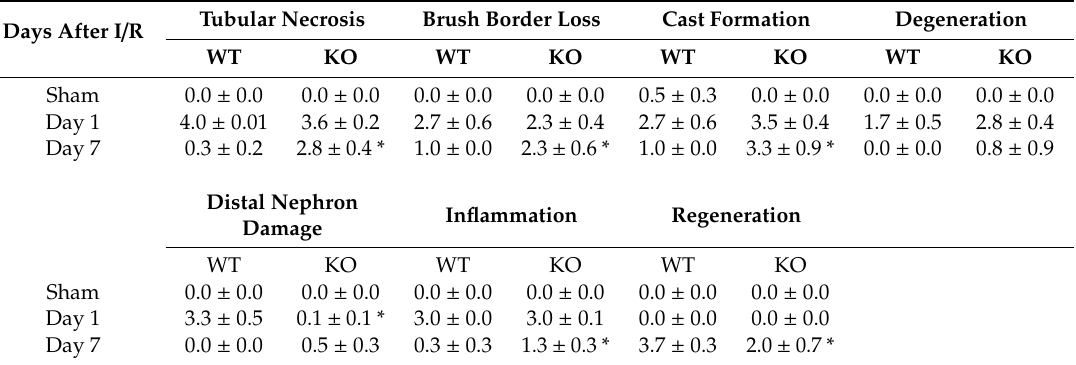
Table 1. Changes in kidney morphology in wild-type (WT) and VDAC1-deficient (KO) mice during recovery after bilateral renal ischemia. Morphological damage to the kidney after ischemia / reperfusion (I / R) was evaluated by light microscopy using fixed kidney sections embedded in para ffi n, processed for light microscopy, and stained with hematoxylin-eosin. The following histologic criteria were used to assess morphological damage to the kidney: tubular necrosis, brush border loss, tubular cast formation, degeneration, distal nephron damage, inflammation (infiltration of the inflammatory cells), and regeneration. These parameters were evaluated on a scale of 0–4: not present (0), mild (1), moderate (2), severe (3), and very severe (4). Results are presented as average ± S.E. of data obtained from kidney sections from wild-type (WT, n = 3) and VDAC1-deficient mice (KO, n = 4). * Values significantly di ff erent ( p < 0.05) from